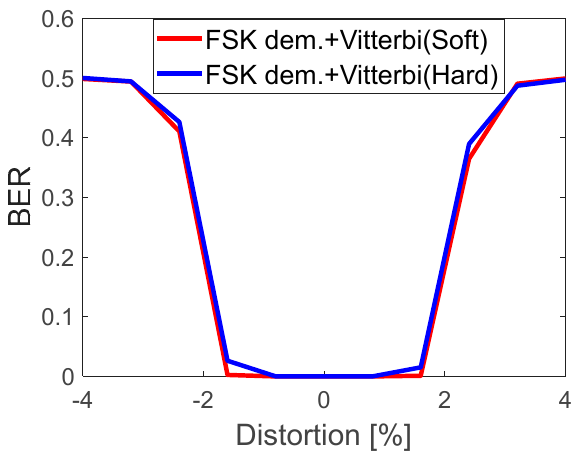
Figure 16. Hard and soft correlator-based FSK demodulator with Viterbi decoder. BER performance vs. e abs